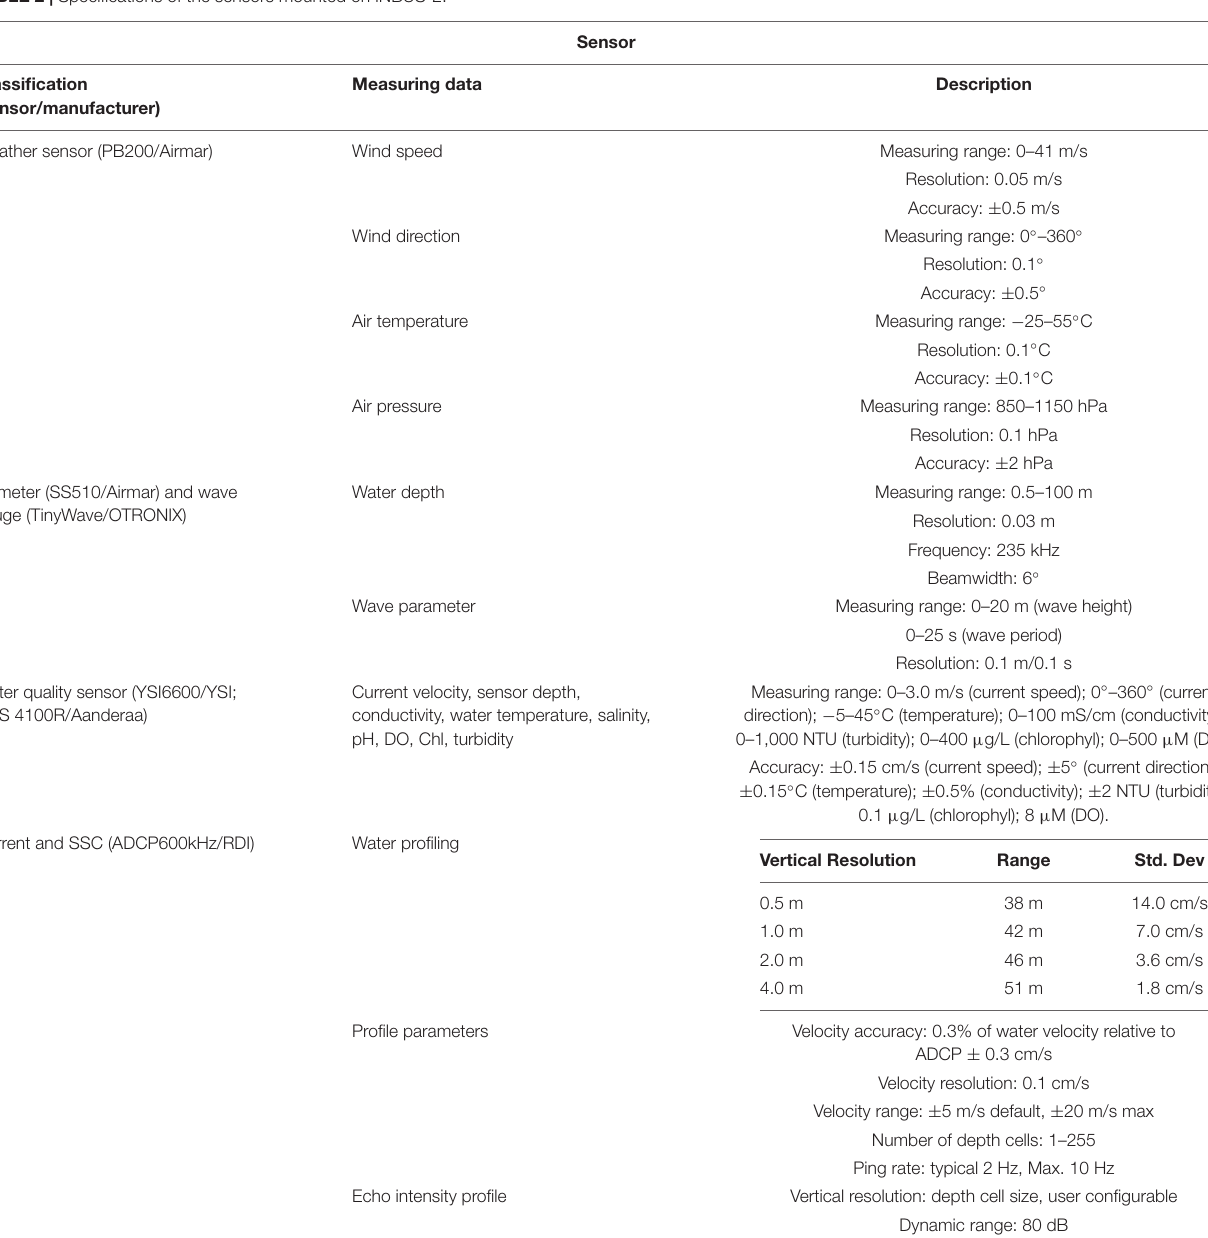
TABLE 2 | Specifications of the sensors mounted on